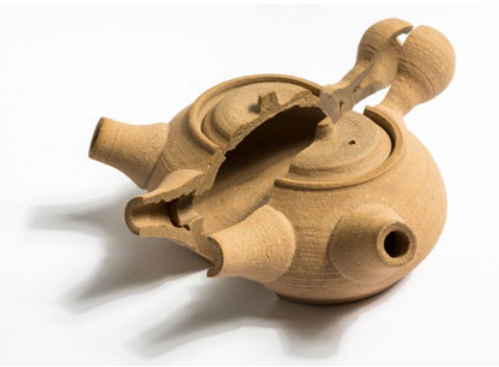
Figure 8.4 Assent. Dissected hand-thrown three-spouted tea pot (7 × 17.5 cm)